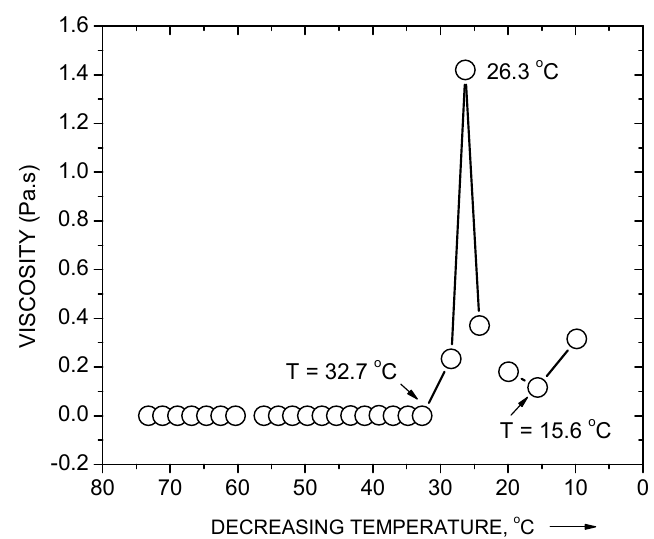
Figure 5. Rheological test for viscosity ( η ) of the molten gel upon cooling. The curve represents the variation of η of the molten gel with cooling from 75 to 10 °C.